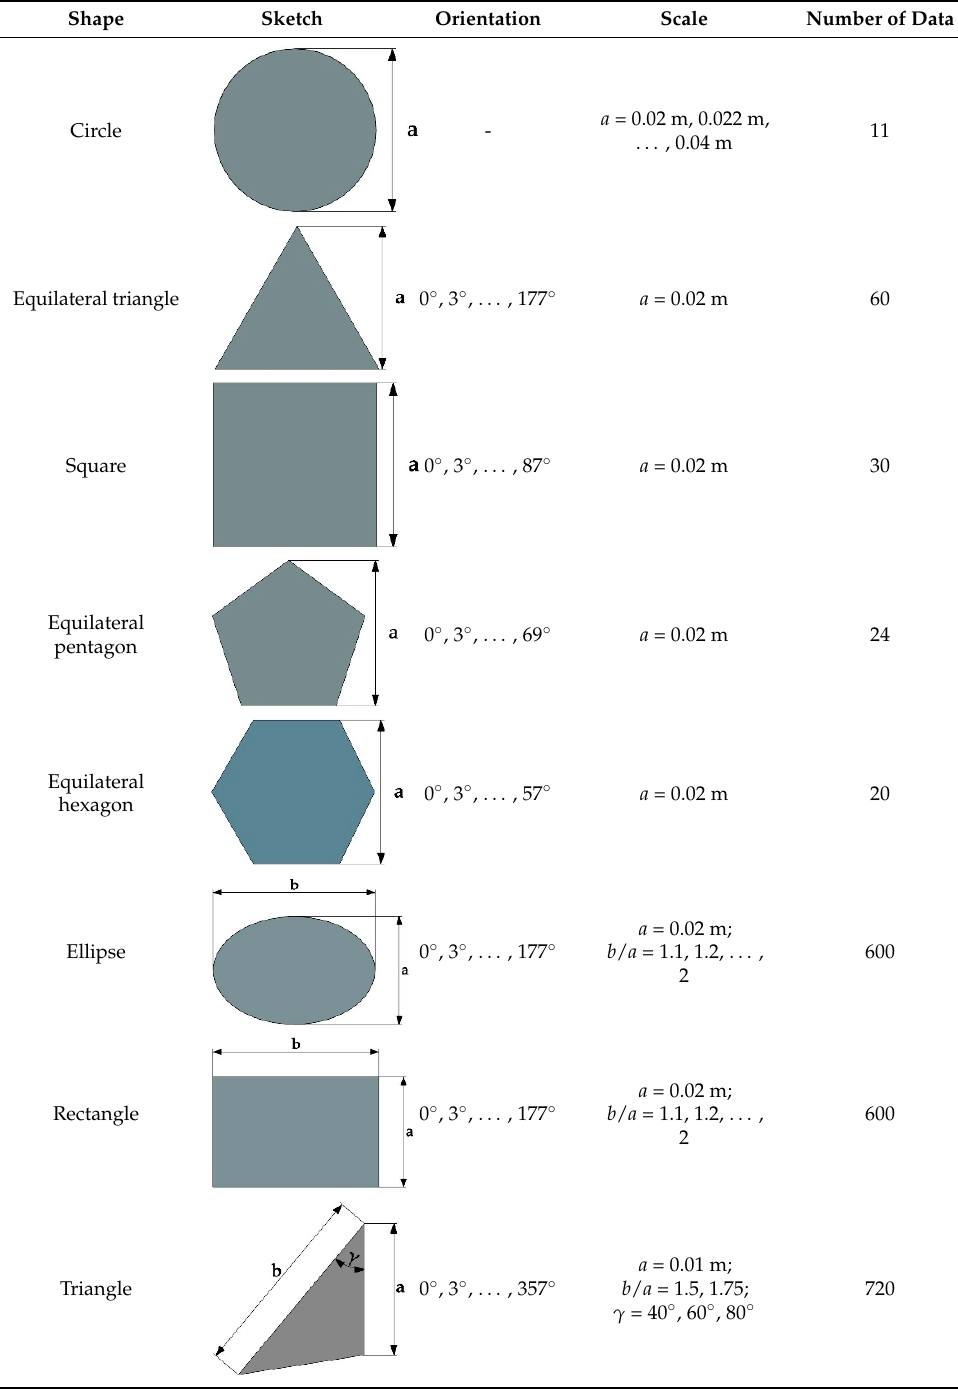
Table 1. Tested geometries.